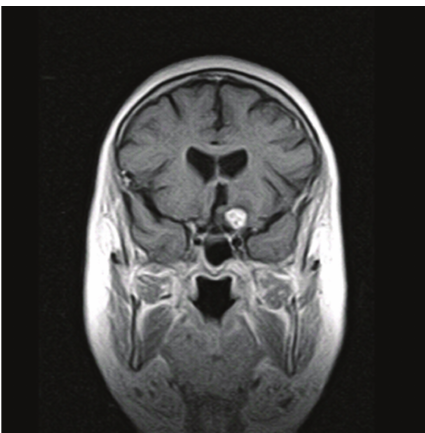
Figure 1: Axial MRI demonstrates avidly enhancing mass in the left paraclinoid region.